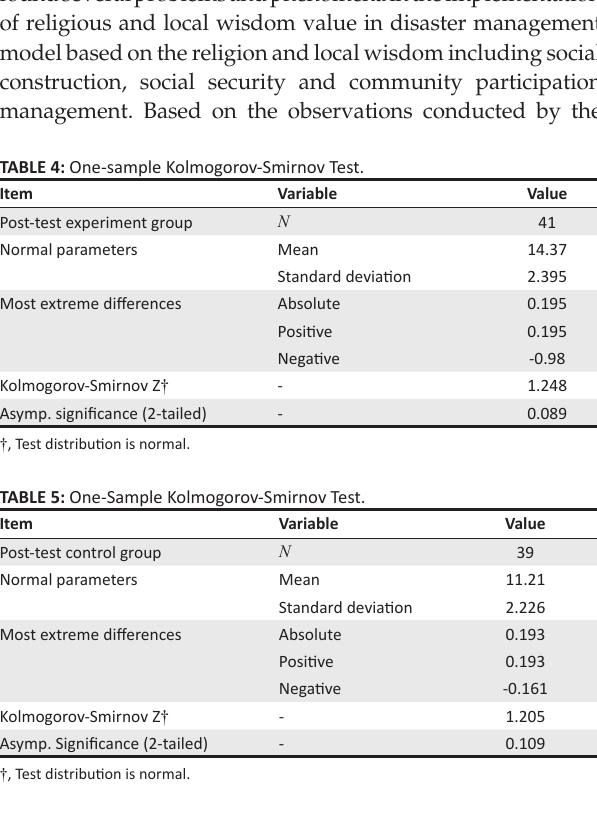
TABLE 6: The result of analysis compare means paired-sample T-test. df T Groups T Significance Description count table